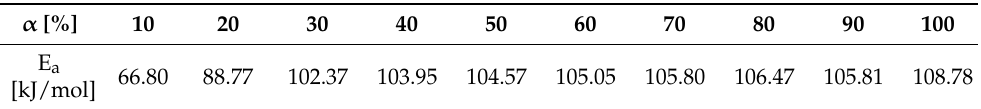
Table 2. Apparent activation energy during thermal